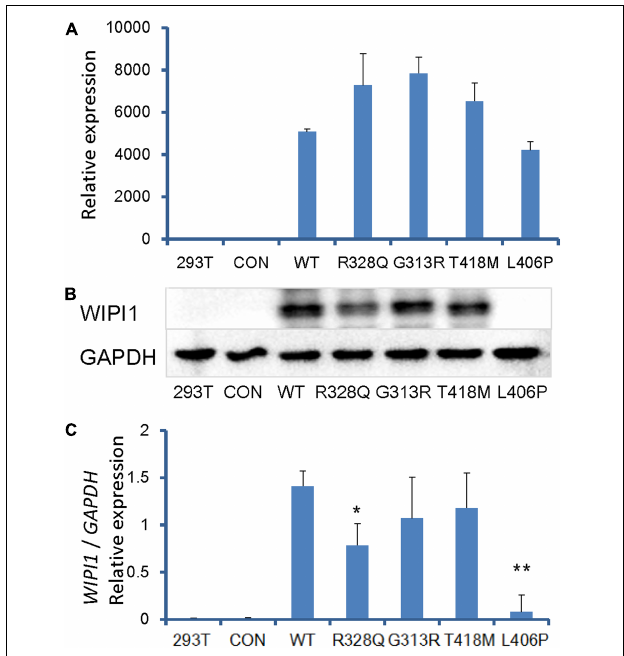
FIGURE 4 | WIPI1 variants and their expression of mRNA and protein. Human HEK 293 cells were cotransfected with pIRES2-dsRed and WIPI1 variants. At 48 h post-transfection, the cells were harvested for real-time PCR and Western blotting. (A) WIPI1 mRNA expression level was not influenced by WIPI1 R328Q, G313R, T418M, or L406P mutations. (B) WIPI1 L406P mutation affected WIPI1 protein expression, while WIPI1 R328Q, G313R, or T418M had no adverse effects on WIPI1 protein expression. (C) Relative WIPI1 mutant protein expression analysis. The data were derived from three independent experiments and expressed as mean ± SD. Data for WIPI1 mRNA and expression were normalized by GAPDH for each sample. Error bars represent standard error/deviation of the mean. The asterisk indicates a statistically significant difference between wild-type and L406P mutation ( ∗∗ P < 0.01; ∗ P <